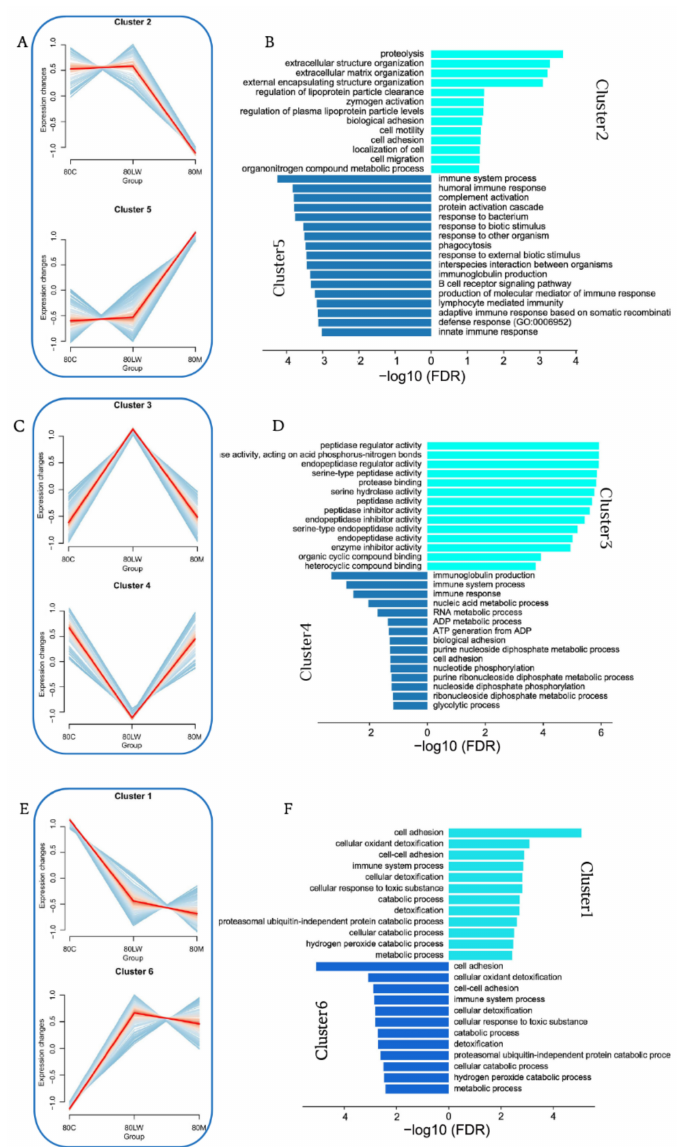
Figure 2. Protein cluster expression and function analysis. ( A , C , E ) Cluster analysis of all proteins based on expression. All the proteins clustered into six clusters, clusters with opposite expression trends were classified into one group, and distinct clusters were assigned to different breed pigs according to the expression patterns. ( B , D , F ) Analysis of the functions of proteins in the different groups. The bar plot shows significant terms by gradient legend as p -value < 0.05. The x -axis corresponds to − log10 (FDR) proteins belonging to the given enriched terms. Different colors represent different clusters in a same